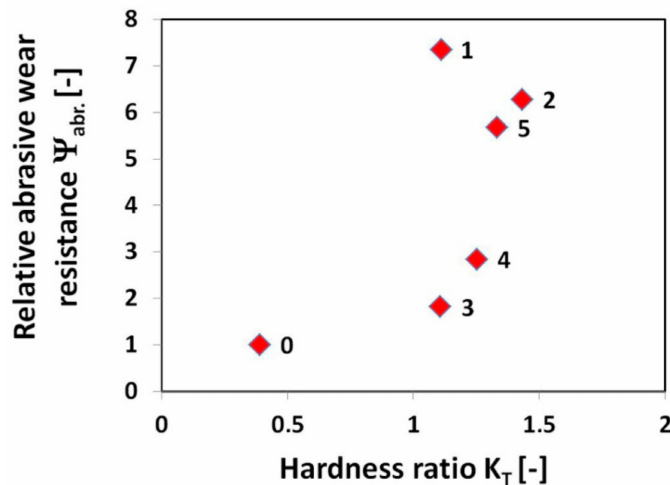
Figure 9. Relative abrasive wear resistance in relation to hardness ratio: 0—16MnCr5 steel; 1—“E520 RB” hardfacing; 2—“RD 571” hardfacing; 3—“LNM 420FM” hardfacing; 4—“E DUR 600” hardfacing; 5—“Weartrode 62”